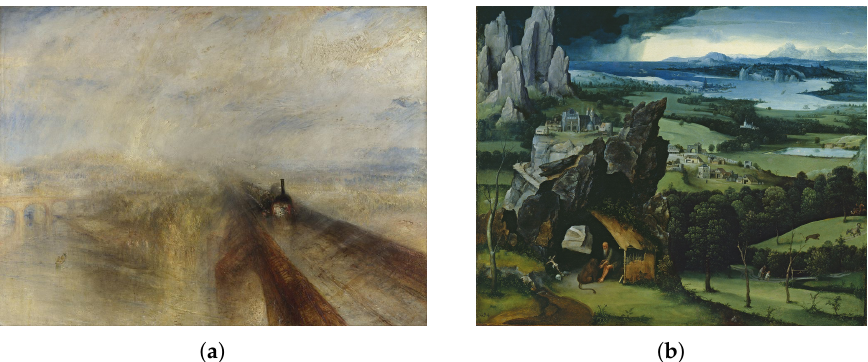
Figure 2. ( a ) An example of highly enhanced aerial perspective in art: “Rain, Steam and Speed” by J.M.W. Turner, 1844. ( b ) A piece where aerial perspective is rendered through bluish gamut: “Paisaje con san Jerónimo” by Joachim Patinir,